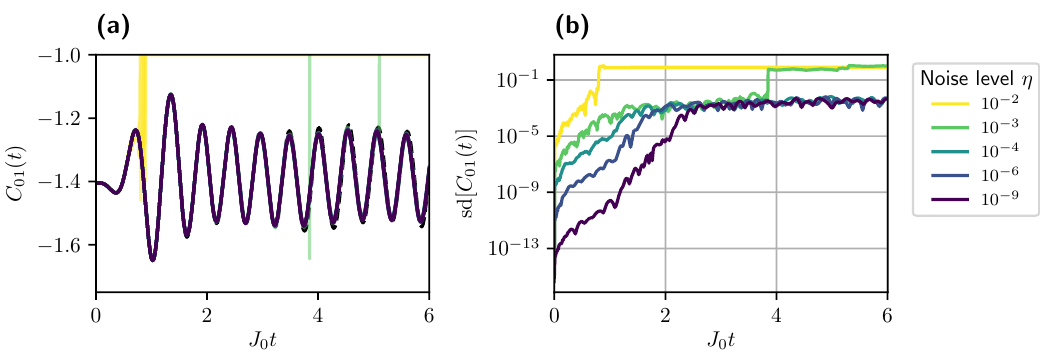
Figure 4: (a) Time evolution of the nearest-neighbor coupling term µ 〉 using the TDVP equation of motion evaluated by full summation = (cid:80) 3 〈 ˆ σ µ C ˆ σ µ = 1 01 0 1 with added artificial noise [ Eq. 8 ] . We show results for the dynamics on the 4 × 4 = 0.20 for an RBM with hidden unit density α = 10. lattice with pulse strength A p For each value of the noise strength η , five independent trajectories are shown as faint lines. The opaque lines indicate the median of the respective curves. (b) Empirical standard deviation between the set of curves in panel (a) grouped by noise strength η .